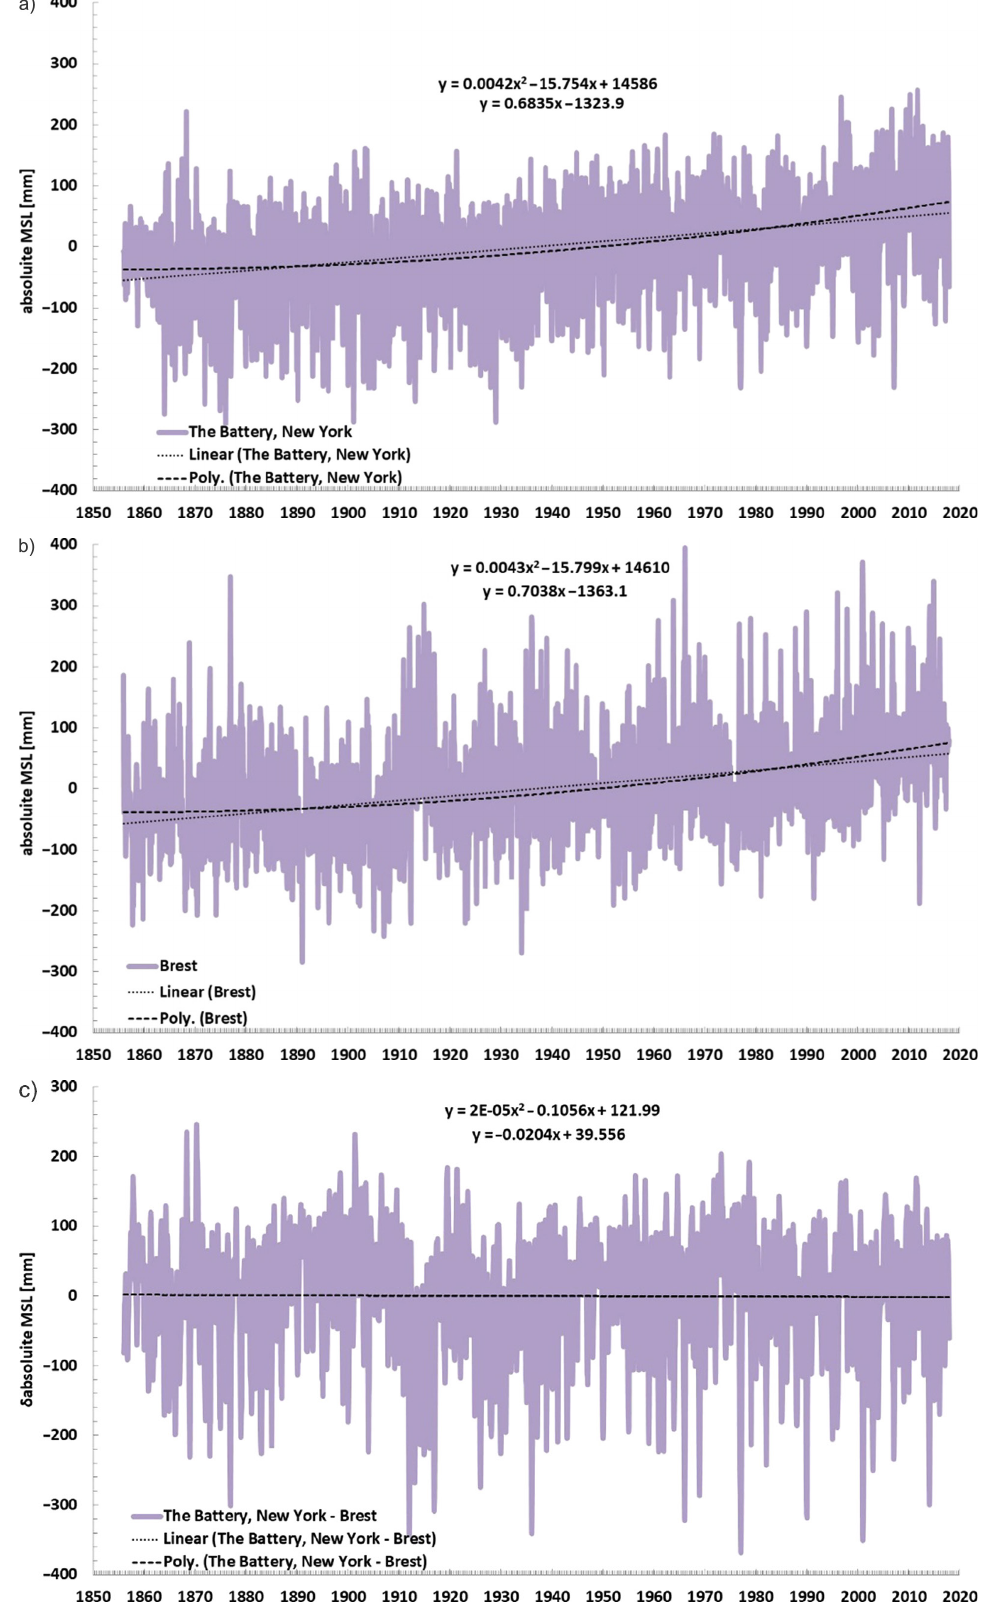
Fig. 1. Absolute mean sea levels in a) The Battery, New York and b) in Brest. Difference between the absolute mean sea levels in The Battery, New York and Brest